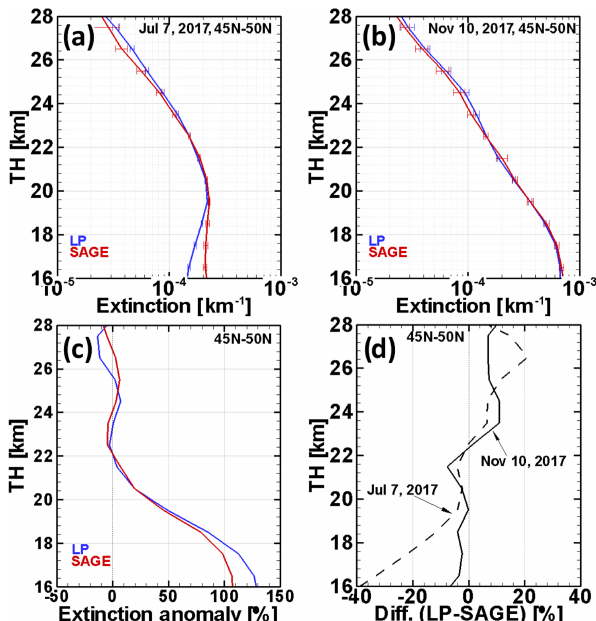
Figure 7. Comparison of the daily zonal mean of OMPS/LP (blue) and SAGE III/ISS (red) aerosol extinction profiles in the 45–50 ◦ N latitude bin (a) before (7 July 2017) and (b) after (10 Novem- ber 2017) the Canadian PyroCb event in late 2017 as well as the (c) extinction anomaly (defined as the deviation from the before case) and (d) the corresponding relative differences between LP and SAGE. The horizontal error bars on the mean extinction profiles in- √ N . Enhanced extinction dicate the standard error of the mean, σ values below 22km after the fire are observed in panel (c) .